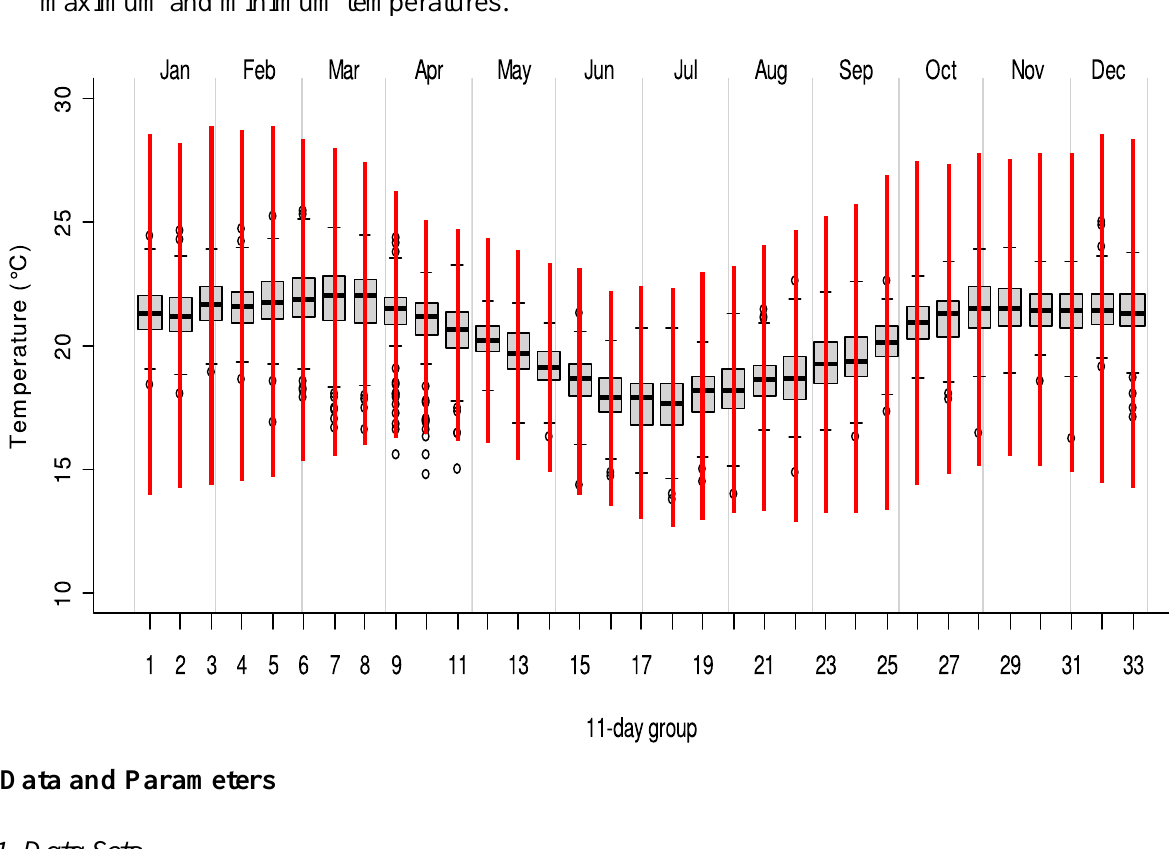
Figure 3. Lake Manyara temperature normal 2001–2009. Boxplots are from daily mean values and red vertical lines represent diurnal variability as derived from median, daily maximum and minimum